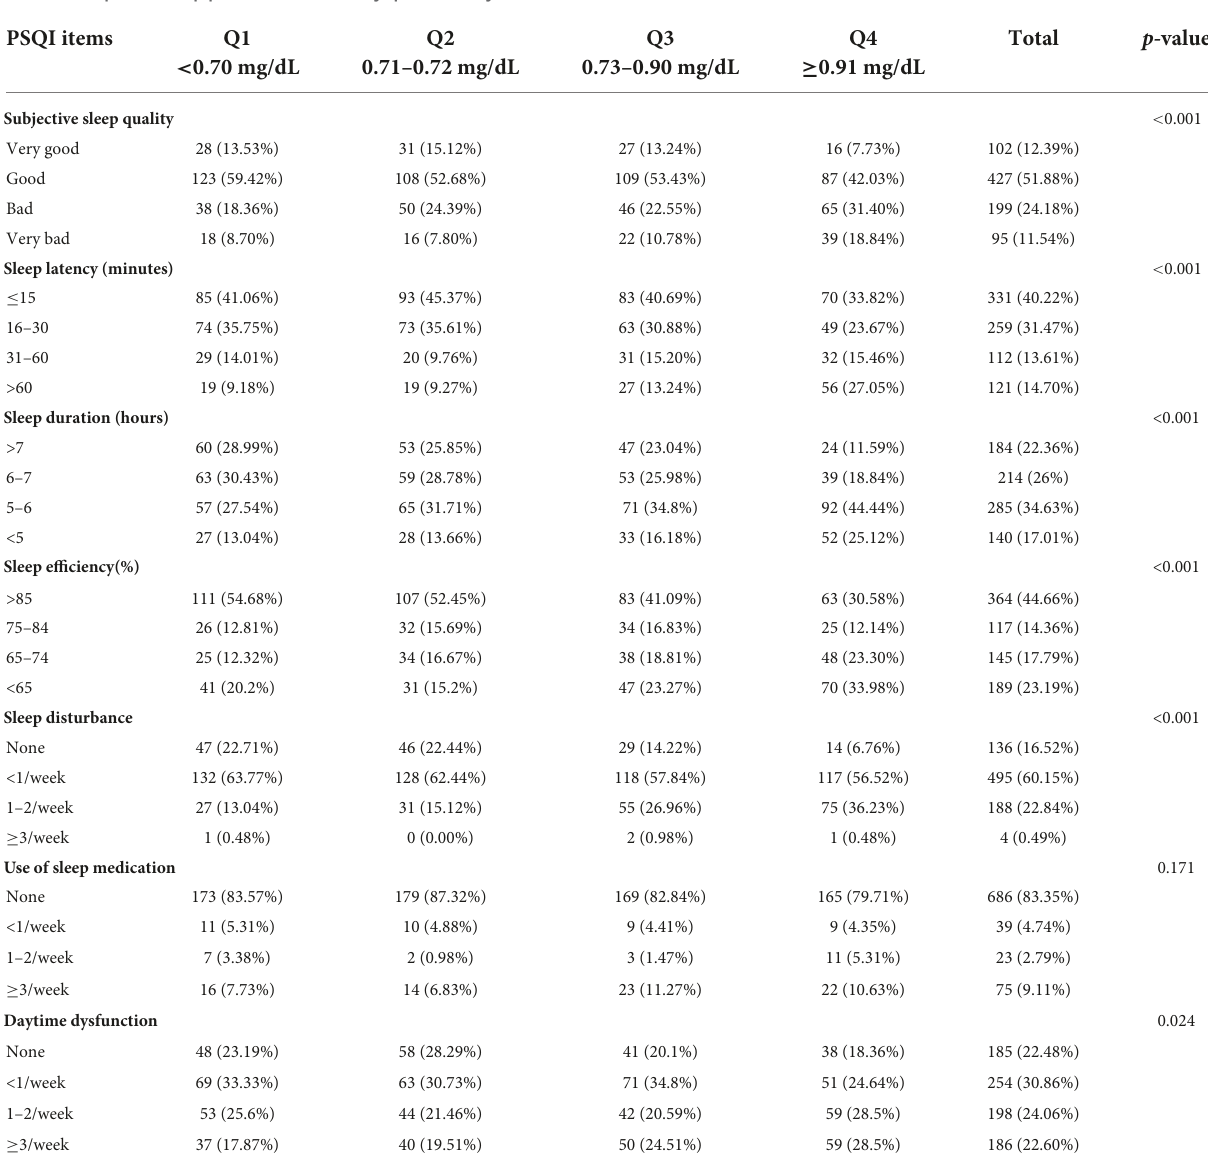
TABLE 2 Separate sleep parameter of PSQI by quartile of cystatin